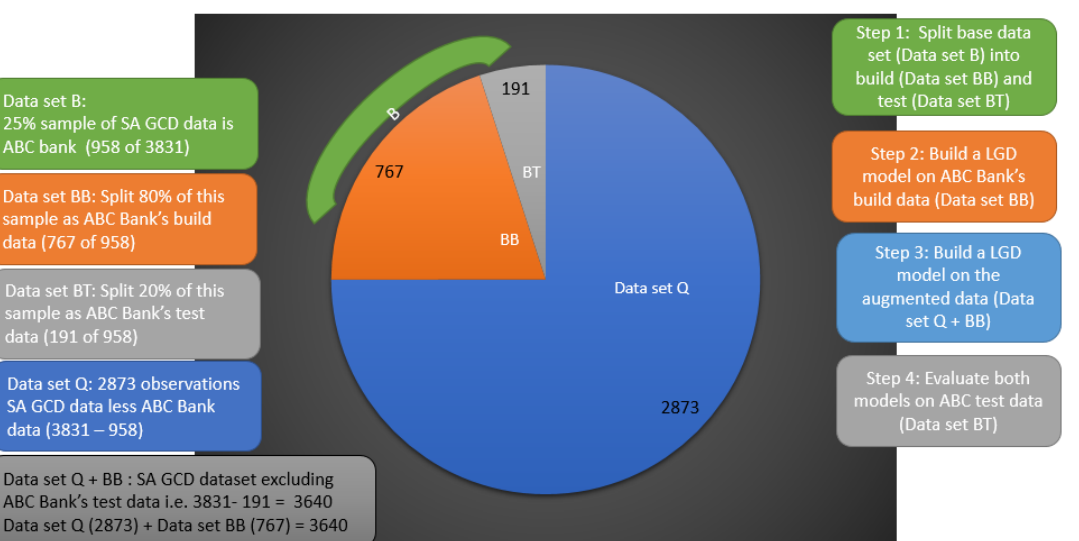
Figure 3. Visual illustration of the data used in case study 1.